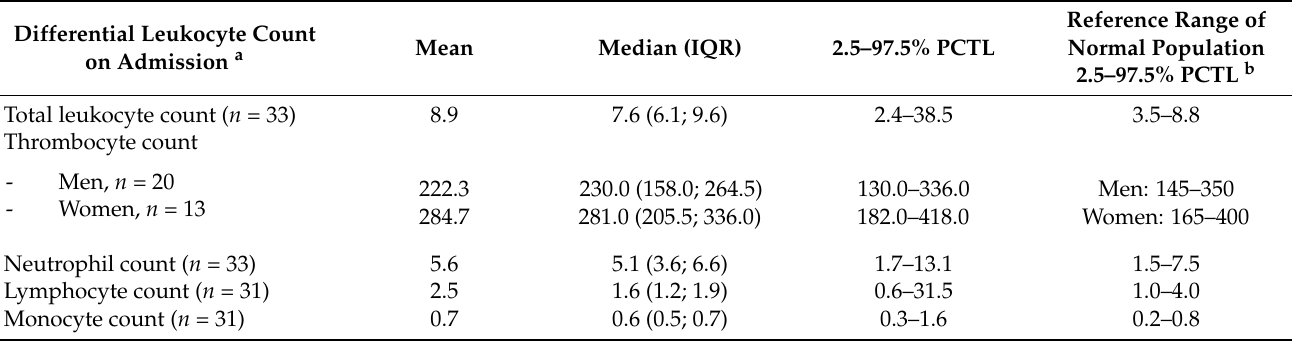
Table 2. Differential leukocyte counts of ischemic stroke patients. As differential leukocyte counts were not available for healthy controls, reference ranges for a normal population are given as